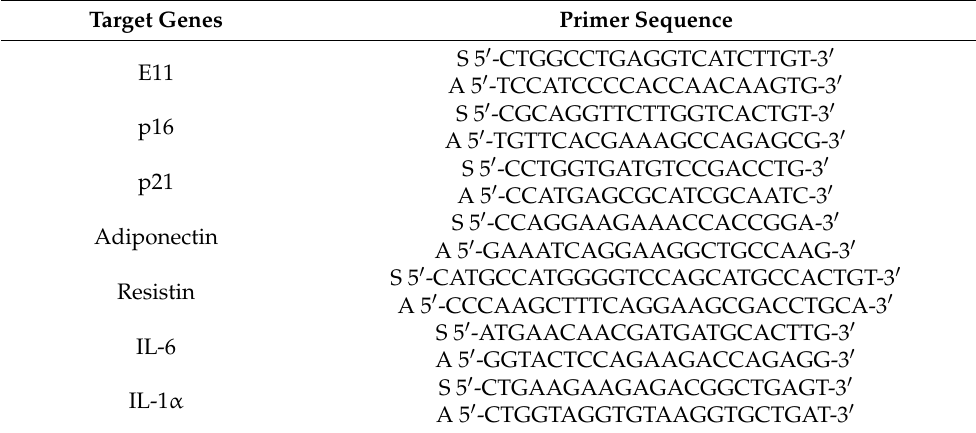
Table 2. Primer sequences for quantitative reverse-transcription